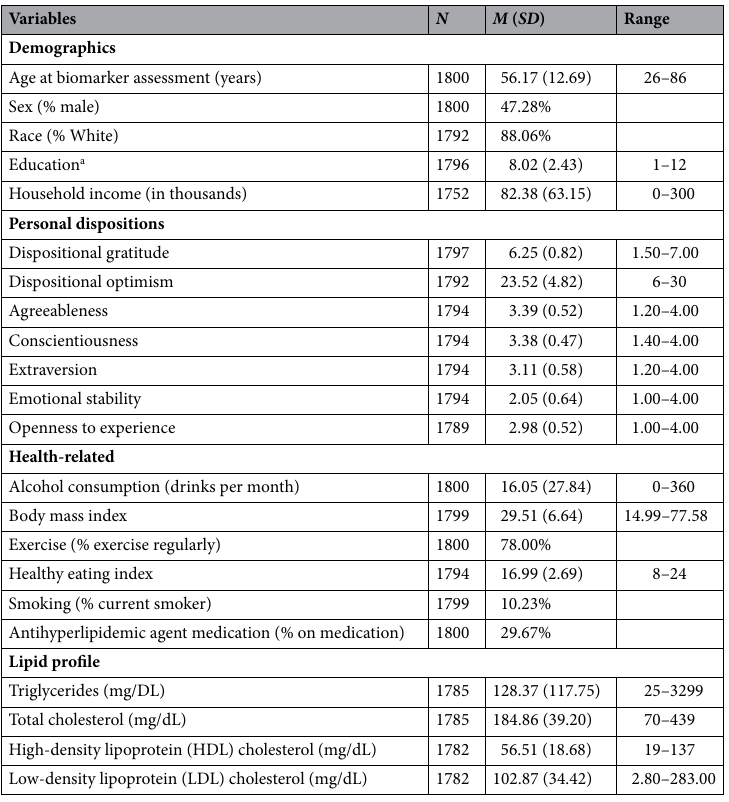
Table 1. Demographics, health behaviors, lipid profile, and other main characteristics of participants in the biomarker projects. Values are shown before imputation. a Education attainment was rated on a scale of 1 (